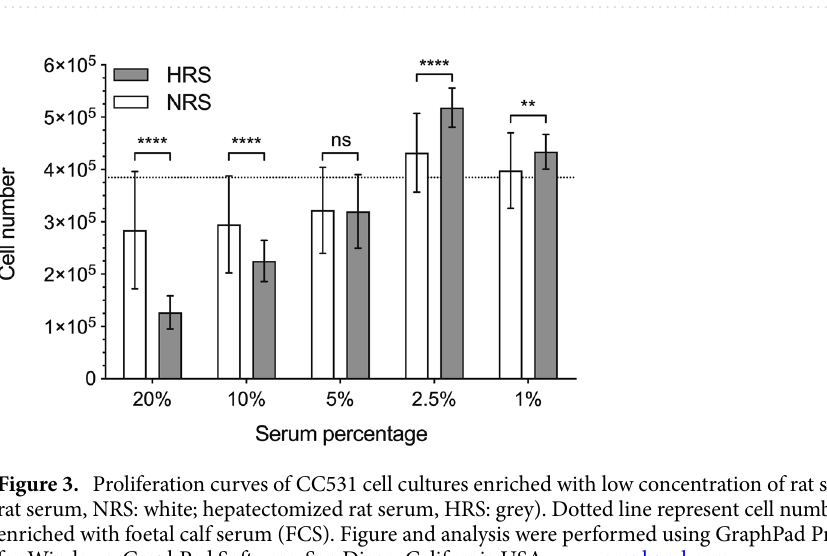
Figure 2. Proliferation curves of CC531 cell cultures enriched with serum from hepatectomized rats. Control (10% FCS) and hepatectomized rat serum (HRS; 1%, 2.5%, 5%, 10%, 20%). Figure and analysis were performed using GraphPad Prism version 6.04 for Windows, GraphPad Software, San Diego, California USA, www.graph pad.com.